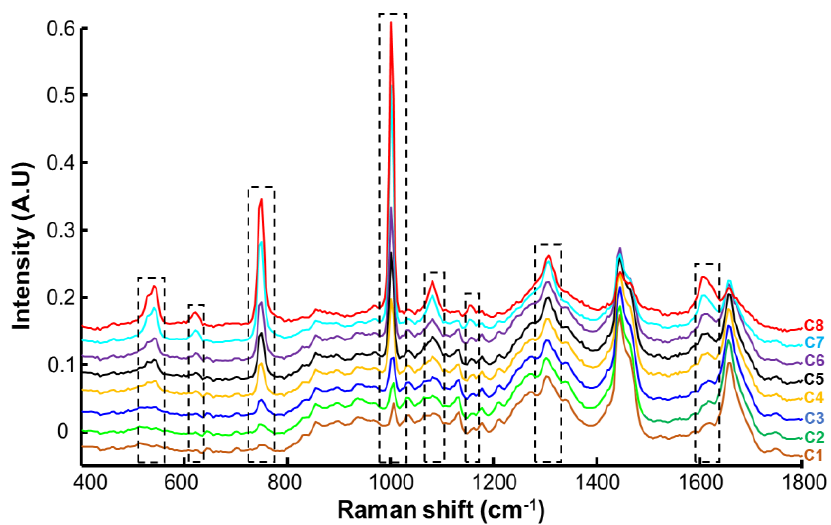
Figure 4. Raman spectra of control SC (C1) and SC infused with resorcinol. a: C2—0.006 mg Figure 4 . Raman spectra of control SC (C1) and SC infused with resorcinol. a: C2 — 0.006 mg resor- resorcinol/mg SC; b: C3—0.008 mg resorcinol/mg SC; c: C4—0.016 mg resorcinol/mg SC; cinol/mg SC; b: C3 — 0.008 mg resorcinol/mg SC; c: C4 — 0.016 mg resorcinol/mg SC; d: C5 — 0.028 d: C5—0.028 mg resorcinol/mg SC; e: C6—0.054 mg resorcinol/mg SC; f: C7—0.130 mg mg resorcinol/mg SC; e: C6 — 0.054 mg resorcinol/mg SC; f: C7 — 0.130 mg resorcinol/mg SC; and g: resorcinol/mg SC; and g: C8—0.257 mg resorcinol/mg SC. Spectra are offset for clarity. C8 — 0.257 mg resorcinol/mg SC. Spectra are offset for clarity .